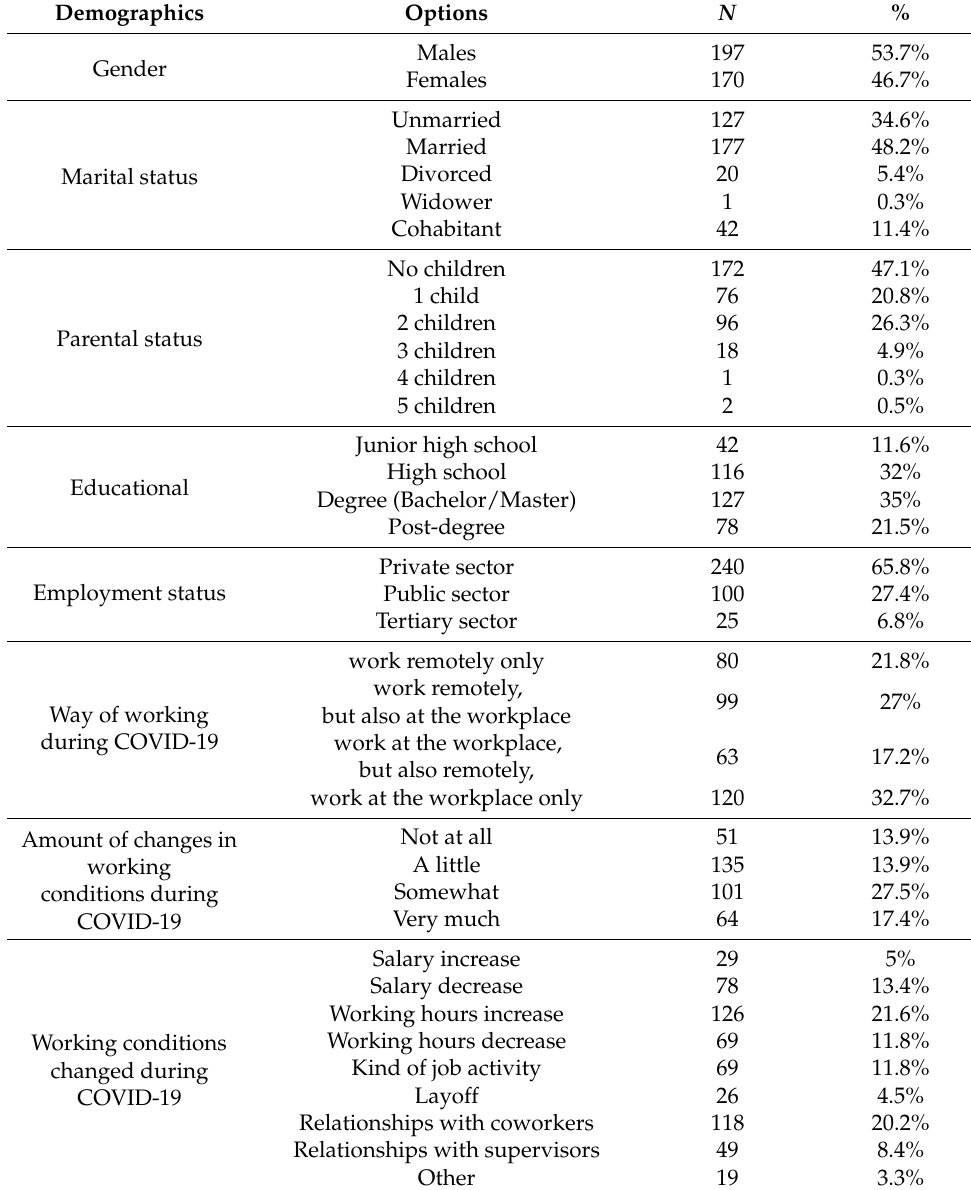
Table 1. Descriptive statistics of the study